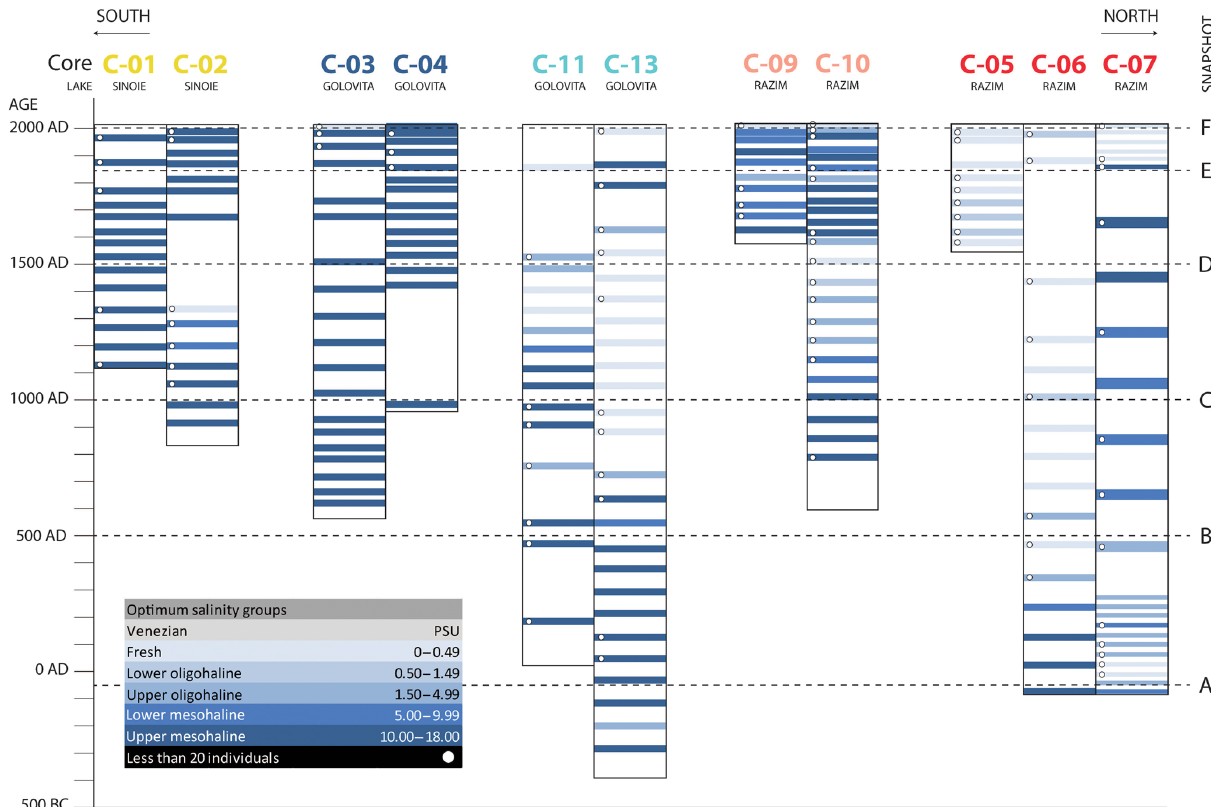
Figure 4. Spatiotemporal salinity variations in the RSL. For each sample, the salinity was calculated by weighted averaging of the species’ optimum salinities. Salinity categories adapted from Strydom et al. (2003). Snapshots referred to in the Discussion are indicated with letters